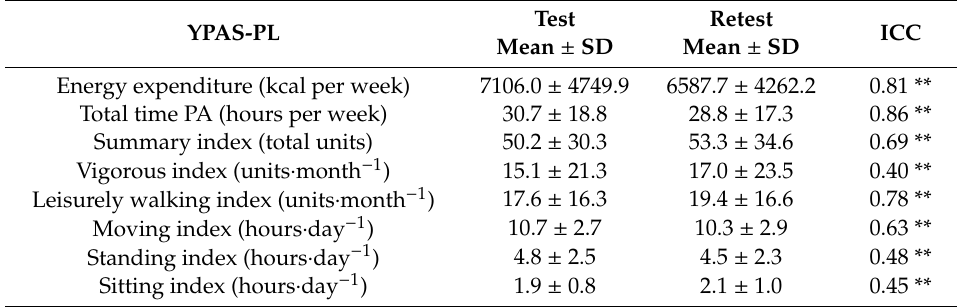
Table 1. Test-Retest Results of the YPAS-PL—Descriptive Statistics and ICC.